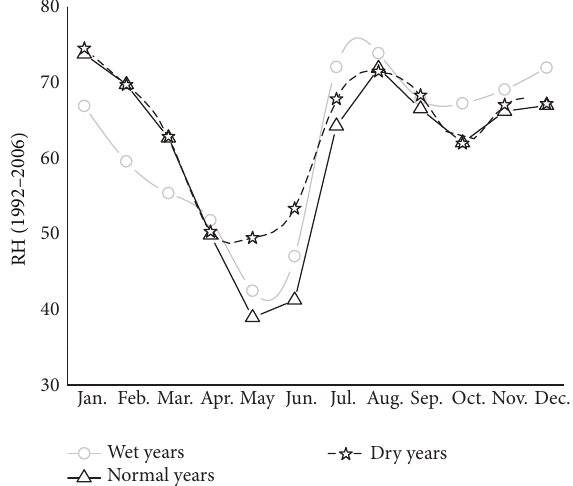
Figure 12: Monthly relative humidity (RH) of Islamabad.